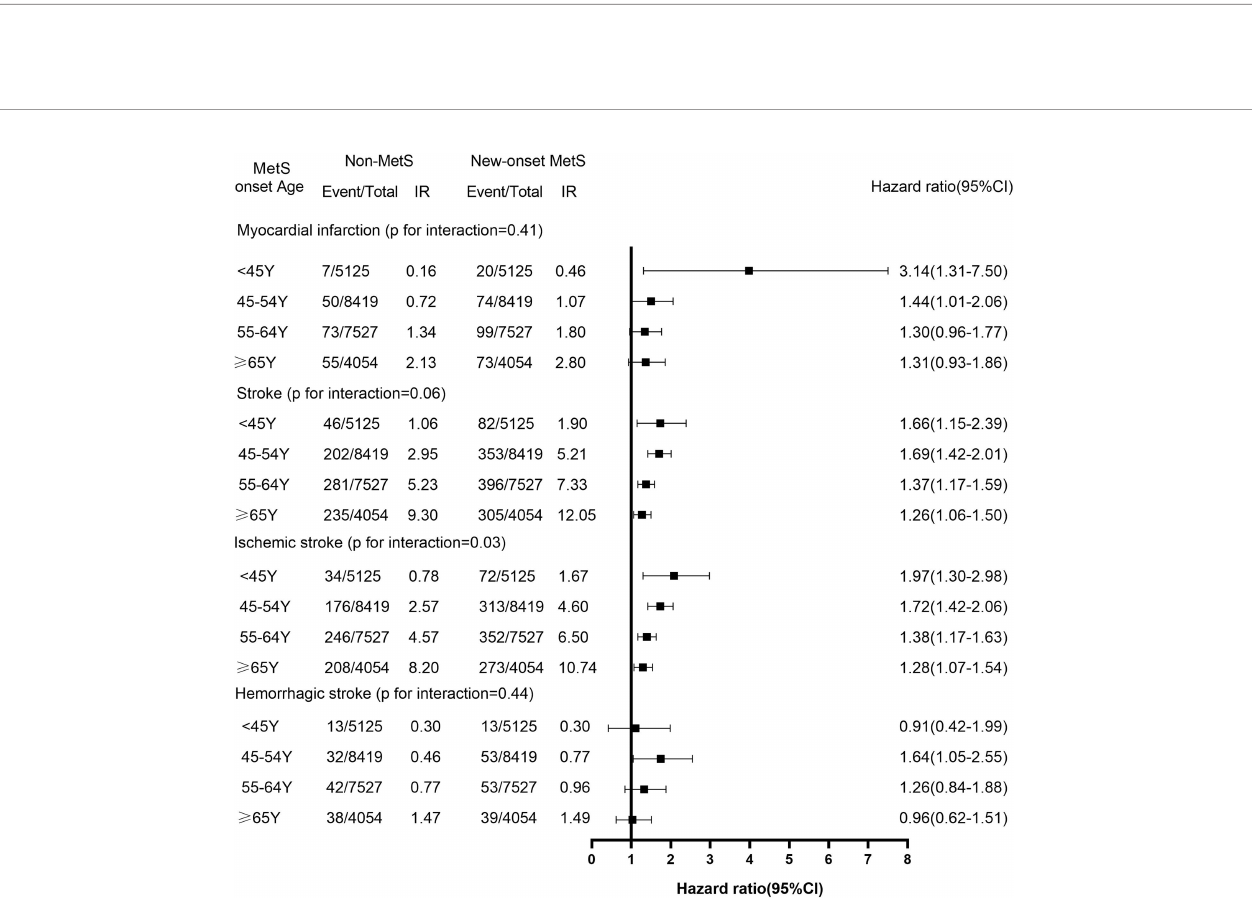
FIGURE 1 | The Hazard Ratios (95%CI) of Incident Cardiovascular Disease of New-Onset MetS Participants Across Age Group. IR, incidence rate (per 1000 person-years). The models were adjusted for HR, hs-CRP, ever-smokers, ever-drinkers, physical exercise, education and family history of cardiovascular disease. CI, con fi dence interval.